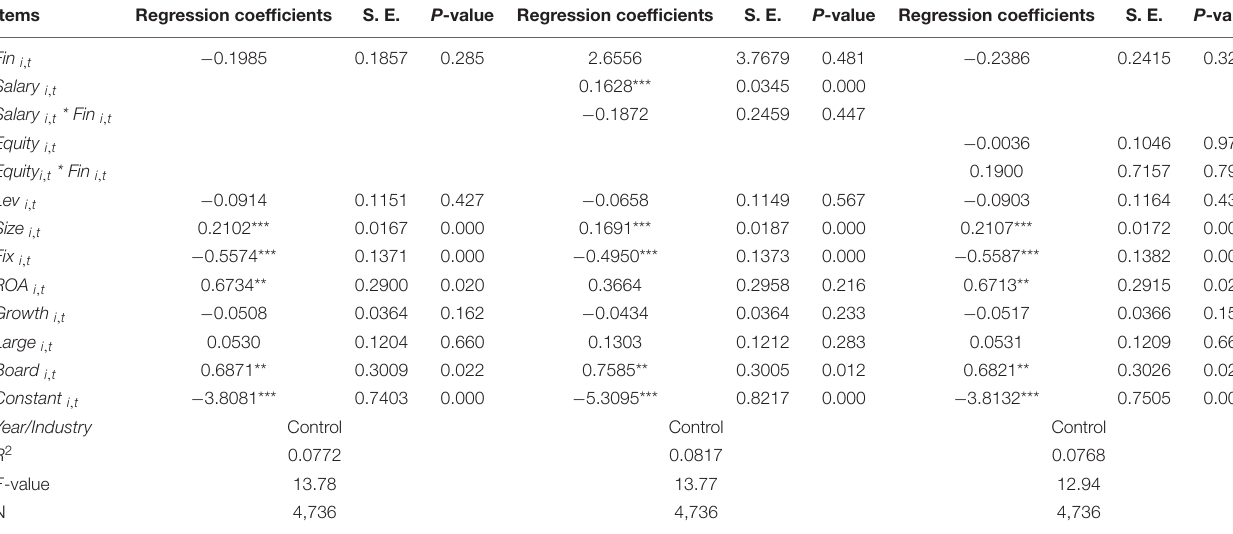
TABLE 12 | Distinguishing the dependence of innovation (non-high-tech